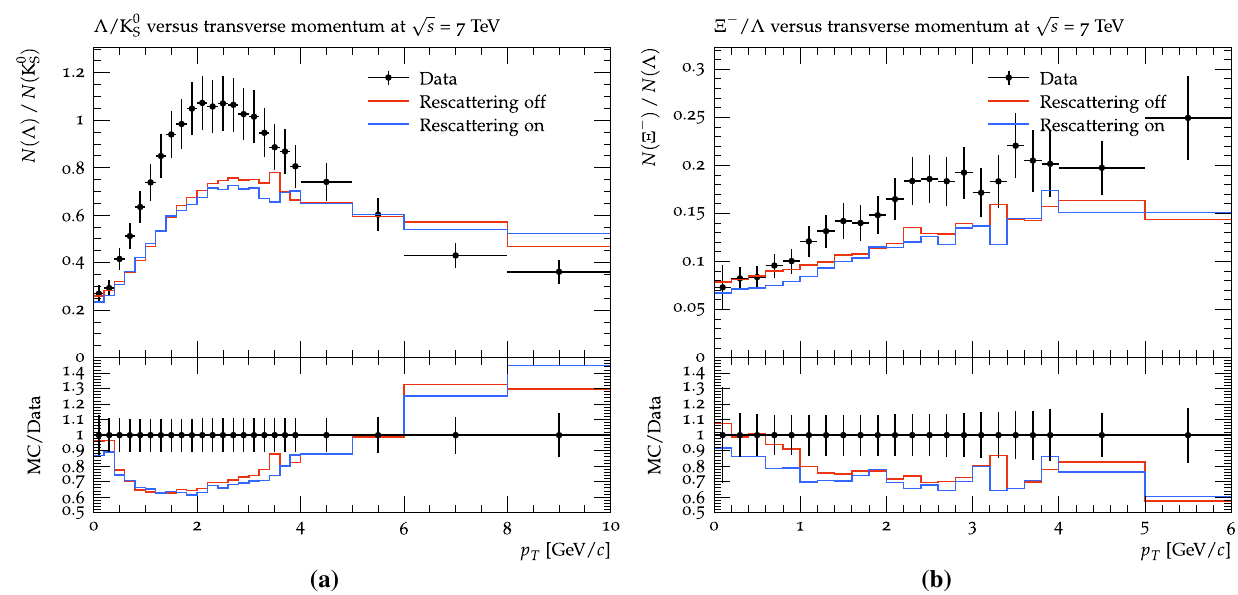
Fig. 24 p ⊥ ratios of a Λ 0 to K S and b Ξ − to Λ 0 in non-single-diffractive events, compared with CMS data